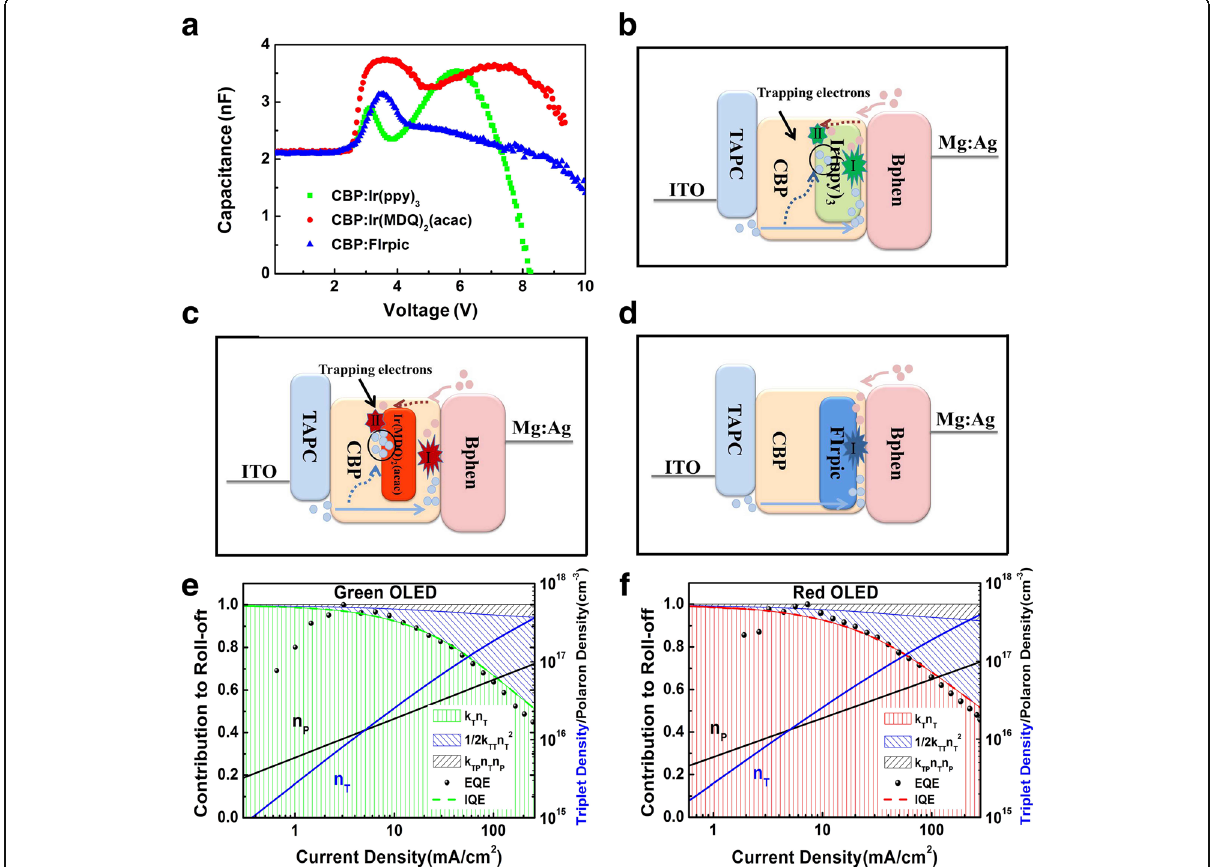
Fig. 6 a C-V plots (scattered points, f = 1 kHz) and L-V curves (solid line) for the three different PHOLEDs-CBP-doped Ir(ppy) 3 (green), Ir(MDQ) 2 (acac) (red), and FIrpic (blue), respectively. The purple dashed lines marked in the graph representing the V on . Where the arrows line point are the inflection points in the curves. Schematic energy-level diagrams on an ITO/TAPC (50 nm)/CBP:10 wt% × (30 nm)/Bphen (50 nm)/ Mg:Ag (120 nm) OLED. The X is b Ir(ppy) 3 (green), c Ir(MDQ) 2 (acac) (red), and d FIrpic (blue). Two recombination mechanisms occur probably in EML, marked as I (Langevin recombination) and II (trap-assisted recombination). Additionally, the blue point represents hole, while the pink point is electron. e Green phosphorescent OLED based on CBP:Ir(ppy) 3 . f Red phosphorescent OLED based on CBP:Ir(MDQ) 2 (acac). Triplet and polaron densities (blue and black lines) are calculated according to Eqs. (4) –